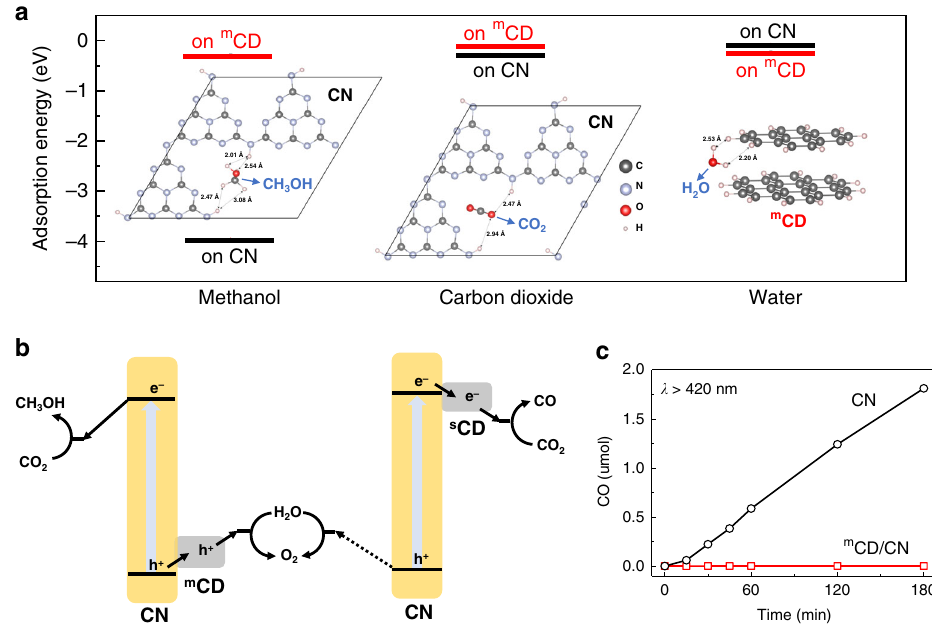
Fig. 4 The fundamental understanding of the high selectivity to methanol. a Adsorption energies and the most stable con fi gurations of CO 2 and CH 3 OH on CN and H 2 O on m CD. b Schematic diagram of photocatalytic CO 2 reduction by the m CD/CN and s CD/CN. The band bending between catalysts and water/CO 2 is not drawn. c The CH 3 OH oxidation test on CN and m CD/CN under visible light. Source data are provided as a Source Data fi